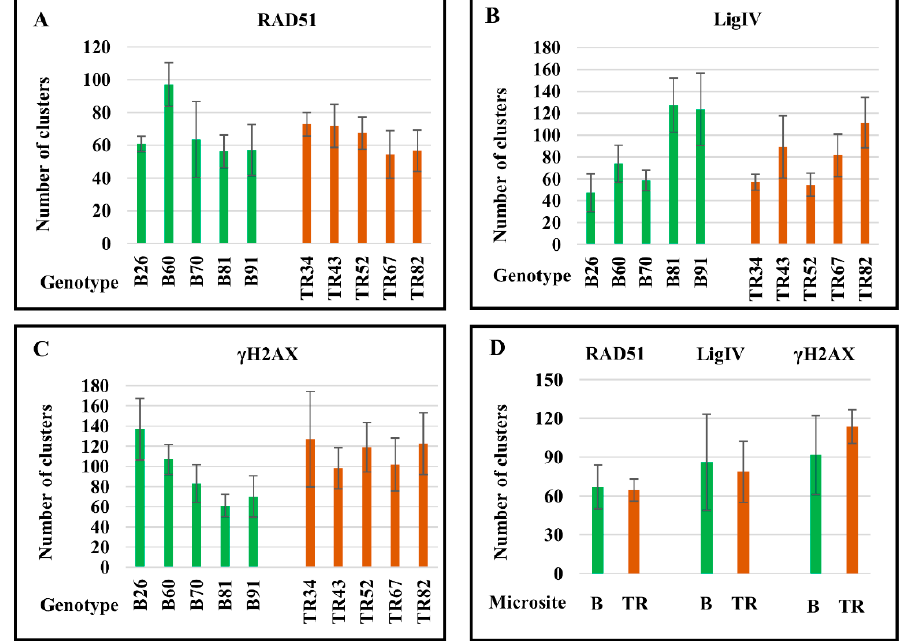
Figure 4. Number of clusters of RAD51 ( A ), LigIV ( B ), and γ H2AX ( C ) on metaphase chromosomes in individual plants of the Basalt (B) and the Terra Rossa (TR) microsites of the Tabigha population. ( D ) The mean numbers of clusters are represented for the B and TR microsites. Standard error bars are shown.